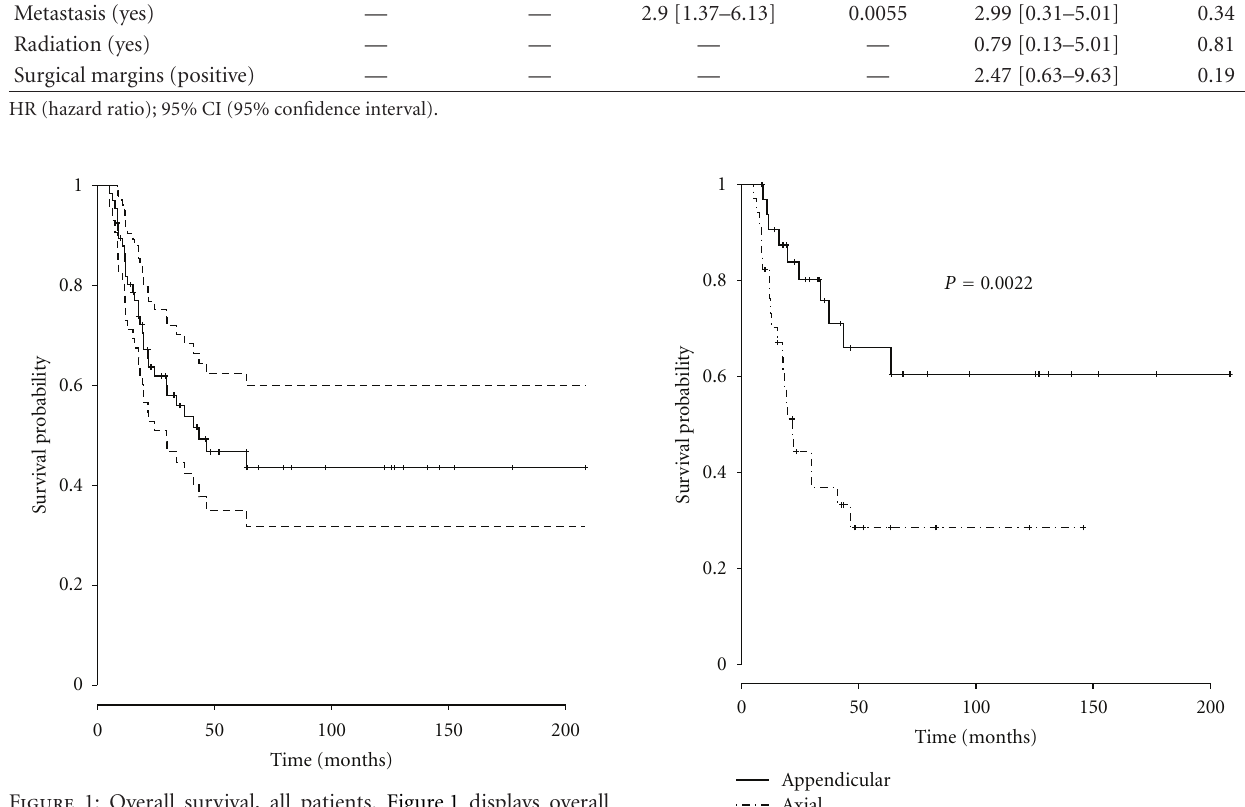
Figure 1: Overall survival, all patients. Figure 1 displays overall survival for all 67 patients. Overall survival was 47% (95% CI = 0.35–0.62) at 5 years and 44% (95% CI = 0.32–0.60) at 10 years. sample size was relatively small and only a limited number of other variables were included in the models.